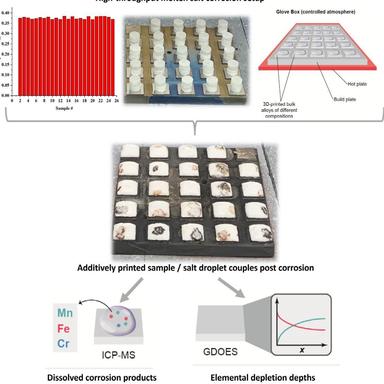
Schematic describing the high-throughput approach to molten salt corrosion of CCA arrays: (upper left) individual salt pellet mass , (upper middle) picture of a CCA array with solid pellets before melting, (upper right) schematic of the melted droplets on the CCA array surface with the heat plate (middle) picture of the CCA arrays after corrosion with the salt droplets still present at the surface of each alloy. Characterization techniques are illustrated: dissolved corrosion products concentrations with IC